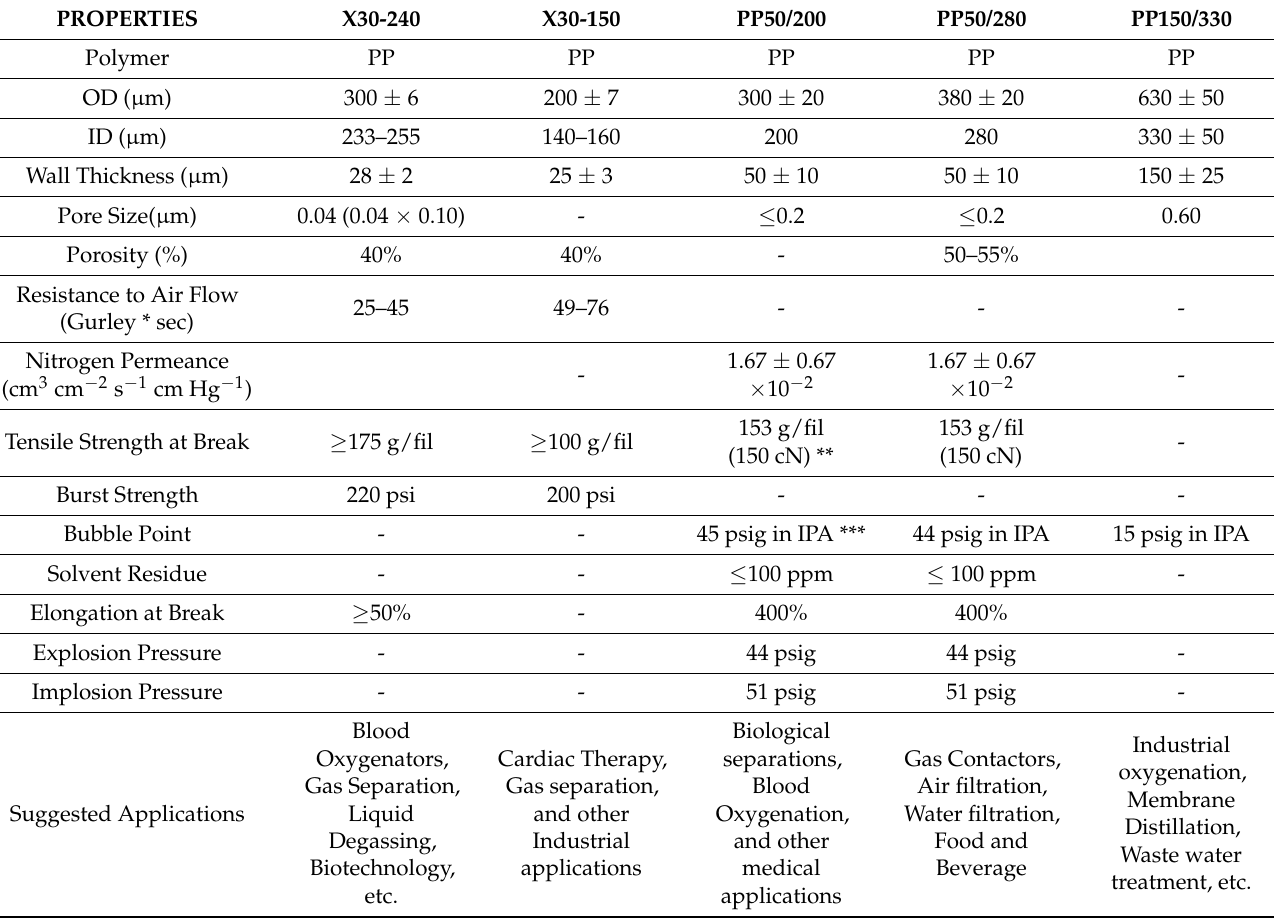
Table 1. Typical properties of hollow fiber membrane (HFM) substrates